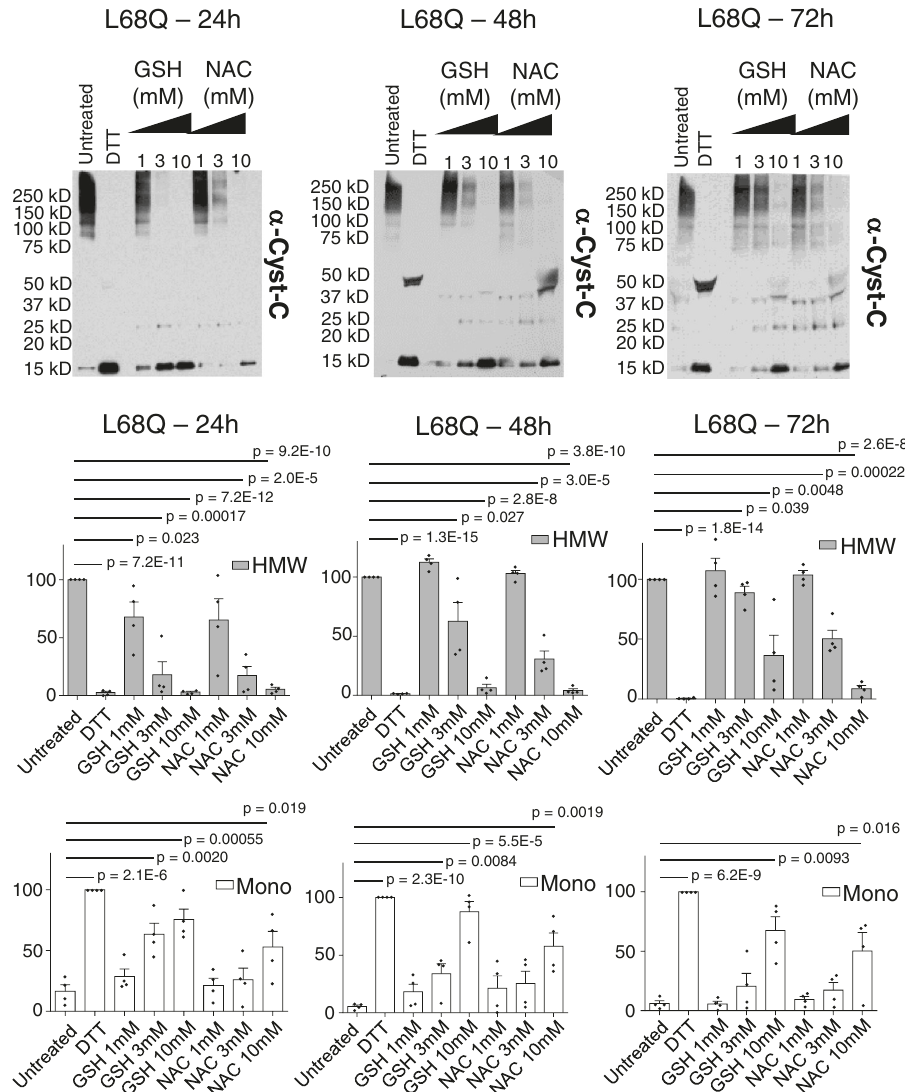
Fig. 4 NAC impairs oligomerization of secreted hCC L68Q. 293T cells expressing WT or L68Q cystatin C were incubated with media containing the indicated amount of either glutathione (GSH) or n-acetyl cysteine (NAC) for 24, 48, or 72 h. Small amounts of supernatant were removed from the cells and analyzed by Western blot at the indicated times. On days 2 and 3, only the supernatants from cells expressing hCC L68Q variant were analyzed. Samples were mixed with 2% SDS without reducing agents prior to electrophoresis, protein levels were detected by anti-cystatin C antibody, and amounts of monomeric hCC (Mono) or high-molecular-weight hCC species (HMW) were quantitated ( N = 4 independent transfections; one-tailed student t test; indicated p values were less than 0.05, without correction for multiple testing, with respect to untreated). Bars are means, error bars represent standard deviation. Experiments from which replicate measurements are derived are shown in Supplementary Fig.